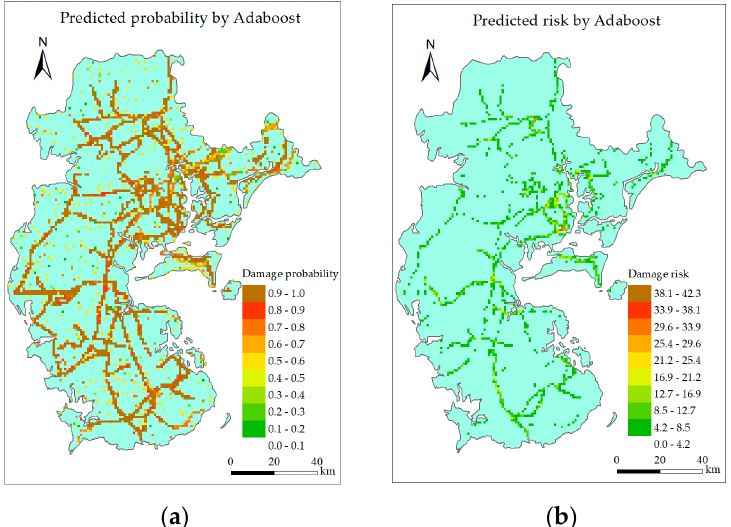
Figure 14. Prediction results of Adaboost. ( a ) Predicted damage probability. ( b ) Predicted damage risk.